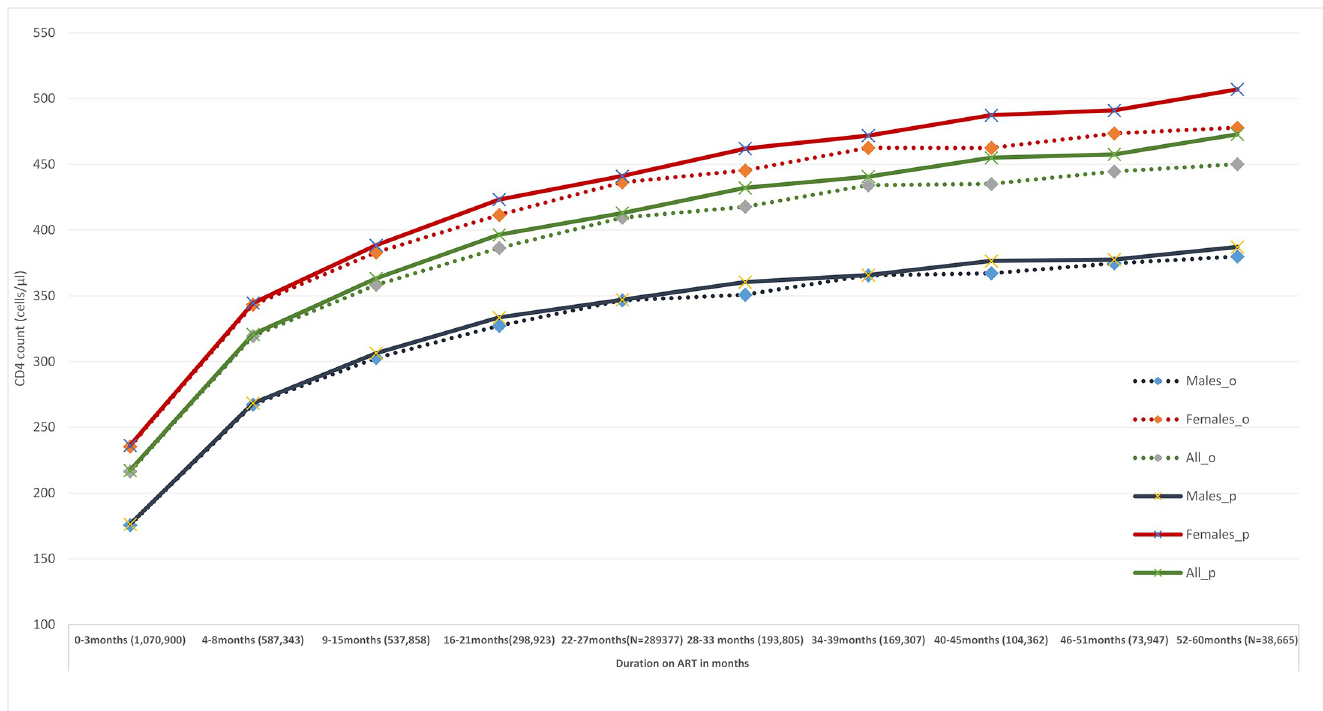
Fig 2. Observed and predicted CD4 counts at different durations on ART.